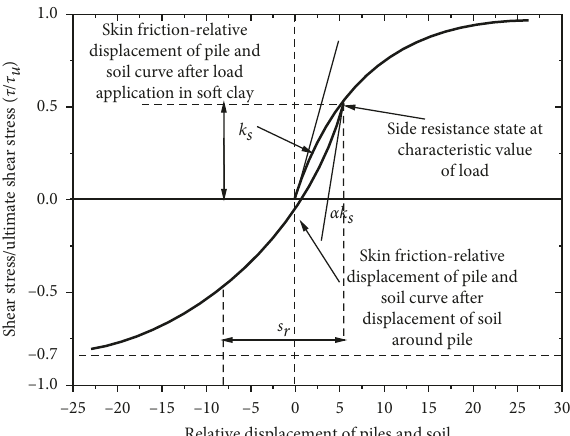
Figure 5: Calculation model of positive lateral resistance and relative displacement of pile and